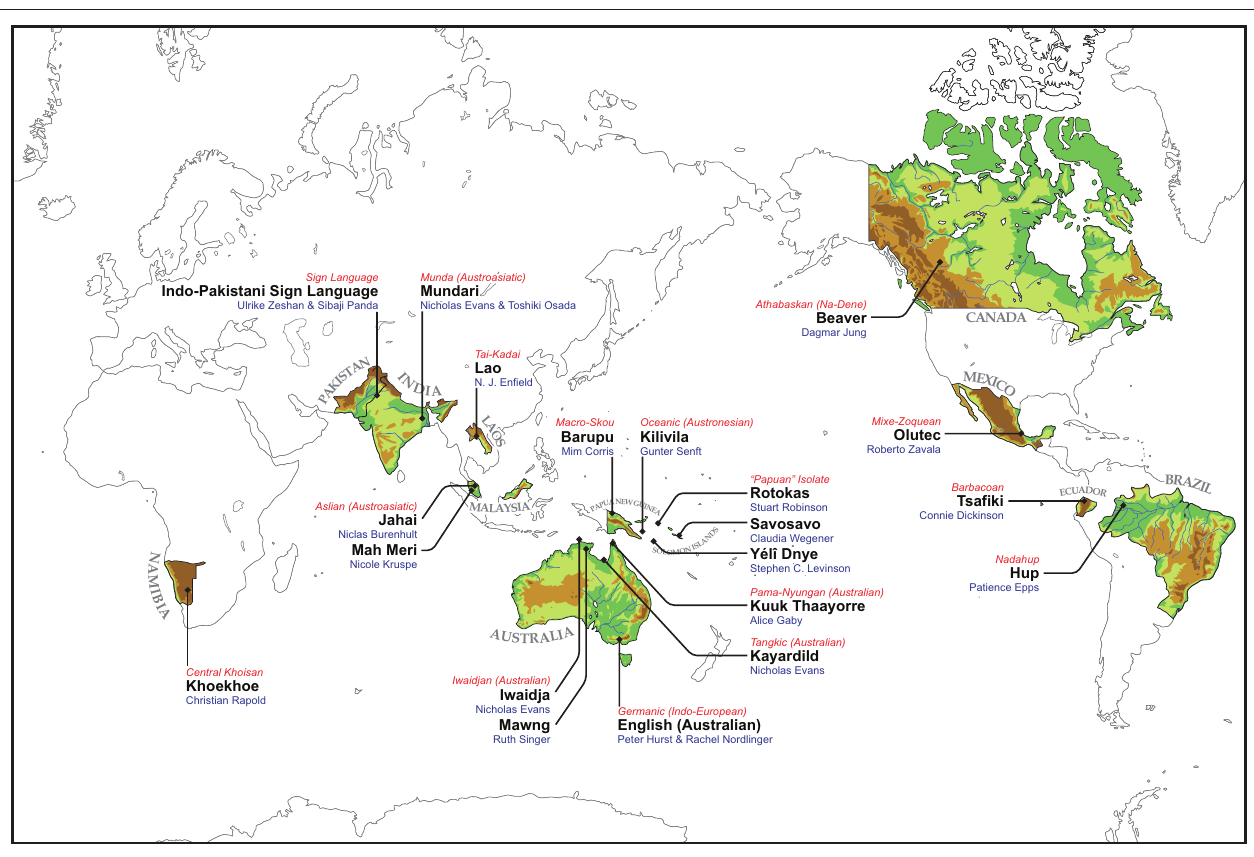
FigurE 2 | Languages in